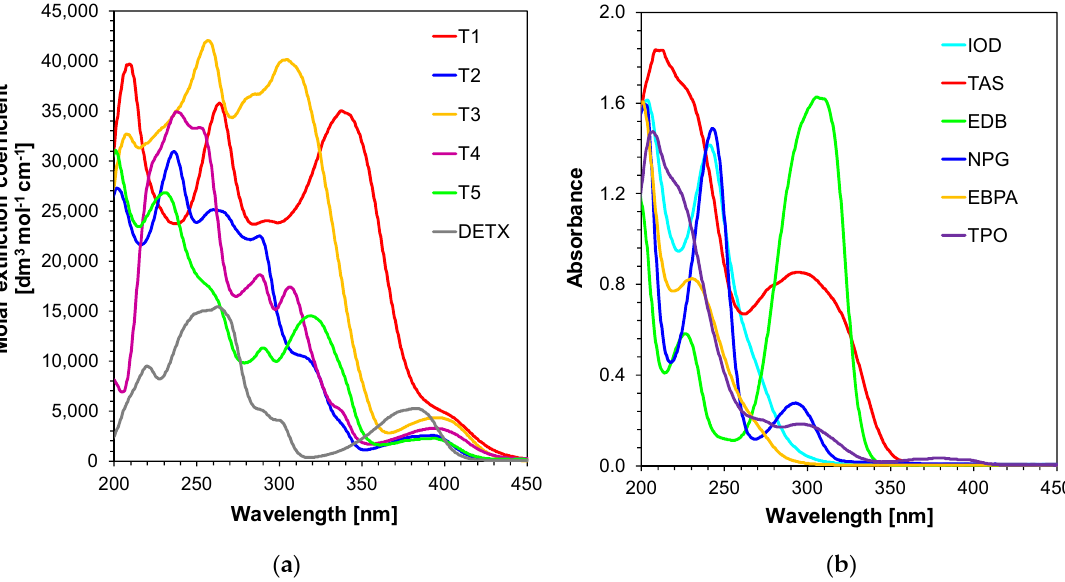
Figure 1. ( a ) Absorption properties of 2,4-diethyl-thioxanthen-9-one derivatives in acetonitrile. ( b ) Absorption properties of onium salts and other additives used as components for photoinitiating systems: IOD—bis(4-t-butylphenyl)-iodonium hexafluorophosphate, TAS—triarylsulfonium hexafluorophosphate salts, EDB—ethyl 4-(dimethylamino)benzoate, NPG— N -phenylglycine, EBPA— ethyl α -bromophenylacetate, TPO—diphenyl(2,4,6-trimethylbenzoyl)phosphine